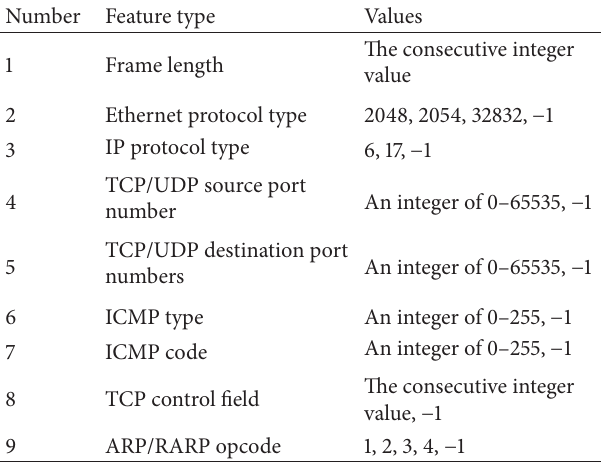
Table 3: Quantization process for the 9 selected packet